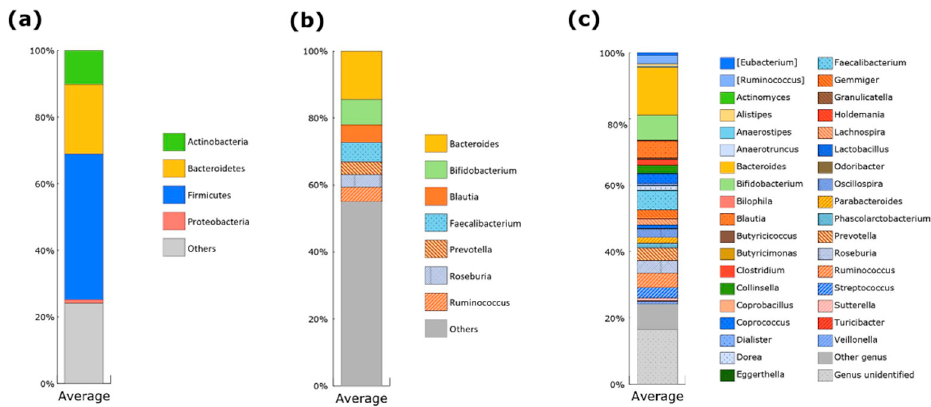
Figure 1. Taxonomic composition of the microbial communities of Japanese subjects enrolled in the study. Cumulative bar chart for average abundance of four major bacterial phyla ( a ), seven predominant genera ( b ), and frequently detected genera ( c ) in the gut microbiota of Japanese subjects enrolled in the study. The frequently detected genera are comprised of 36 genera, which were detected in more than 50% of the